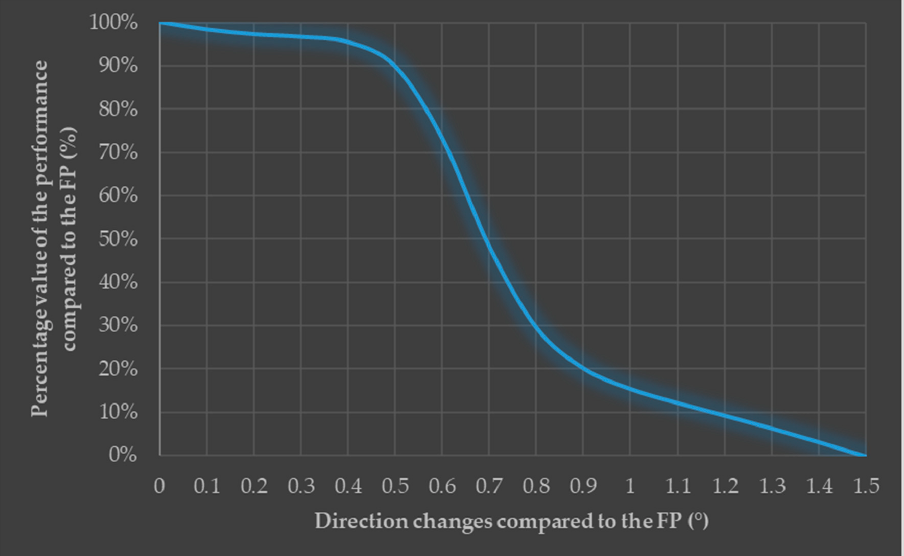
Figure 10. Changes in the performance of CPV technology as a result of 0.1° directional changes compared to the focus point (FP) based on the created rational polynomial regression model (CPV cell diameter: 3 mm). Table 3. The effect of directional changes on CPV performance (x = change in orientation (°); f(x) = percentage value of the performance compared to the FP) (CPV cell diameter: 3 mm). Description Equation